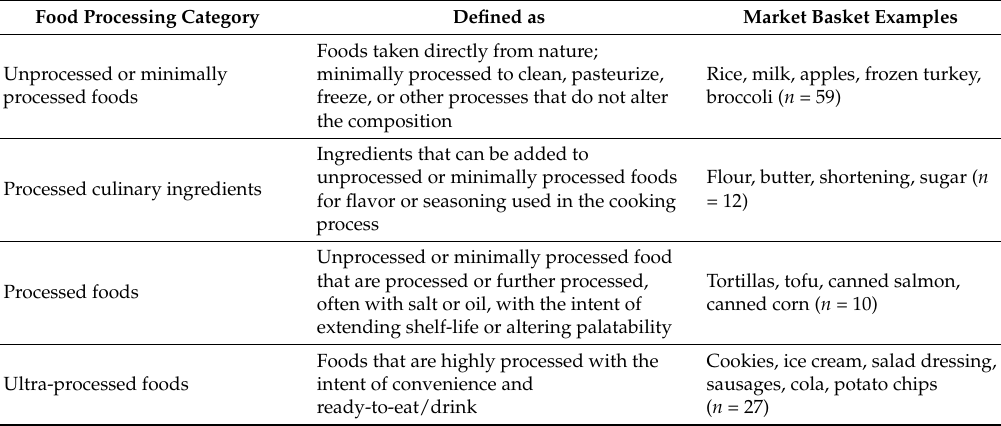
Table A2. Food processing categorization based on the level of processing.